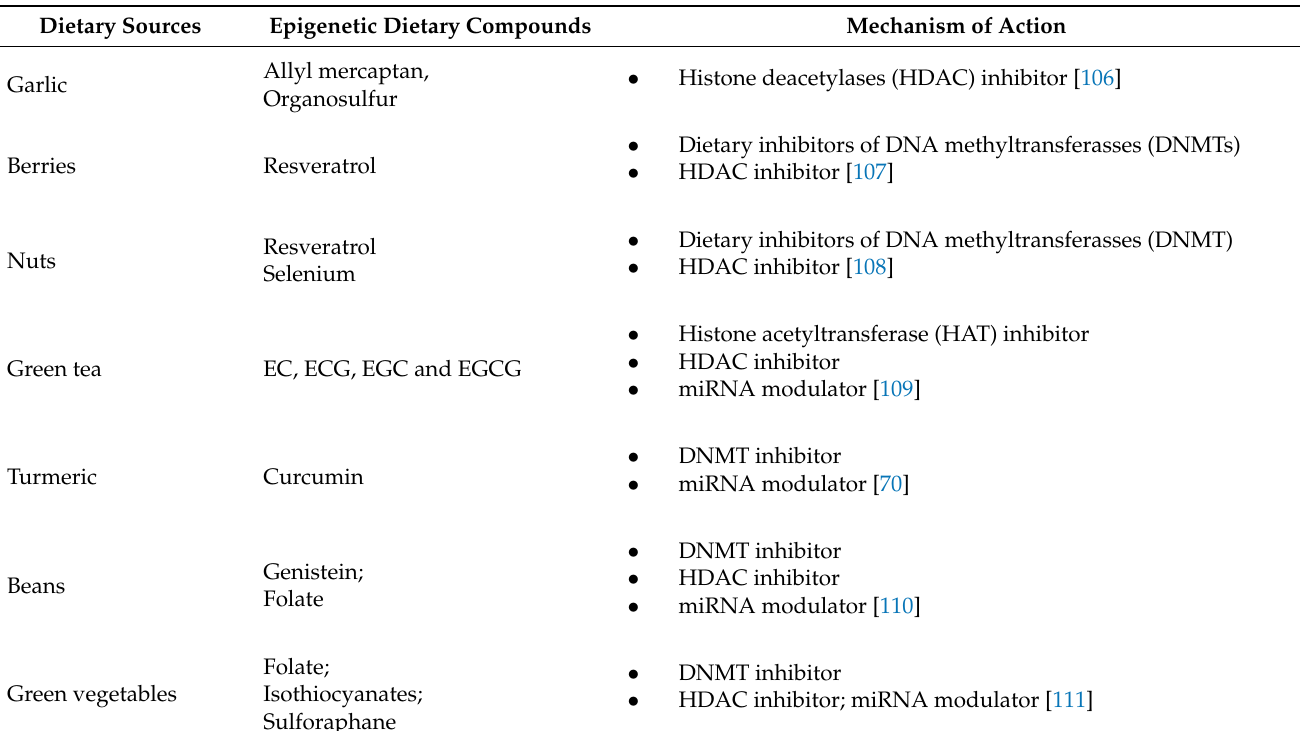
Table 2. Table showing dietary sources of polyphenols and its epigenetic dietary compounds that affect cancer